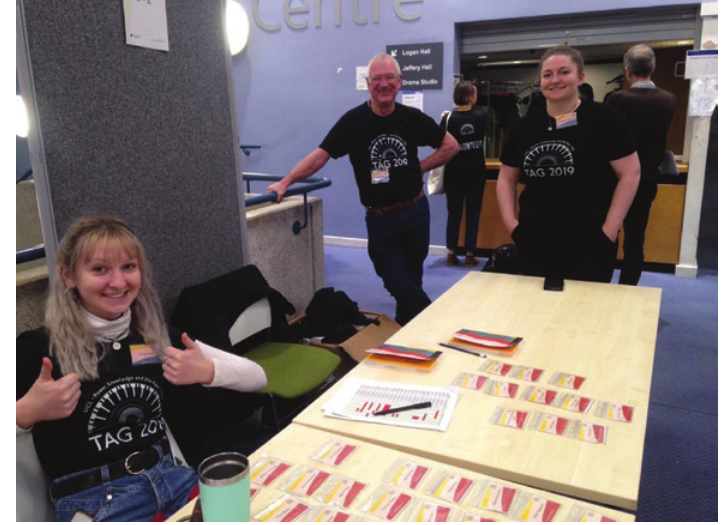
Figure 2 TAG volunteers at the registration desk. (Image credit: Andrew Gardner and Edith Colomba)